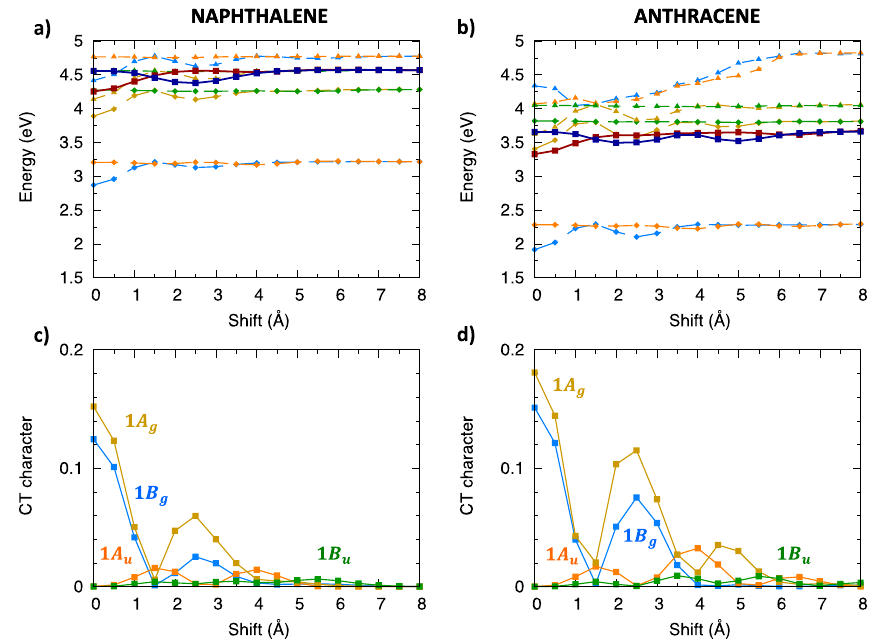
Figure 8. Lowest energy triplet exciton states of ( left ) naphthalene and ( right ) anthracene: ( a , b ) adia- batic excitation energy profiles of the low-lying exciton states depicted with different color codes for different symmetries: yellow for 𝐴 𝑔 , orange for 𝐴 𝑢 , blue for 𝐵 𝑔 and green for 𝐵 𝑢 . The lowest energy exciton states not included in the diabatization procedure are also shown (dark blue, 𝐵 𝑔 symmetry, dark red, 𝐴 𝑢 symmetry); (c, d) 𝐶𝑇 character of the lowest four exciton states.